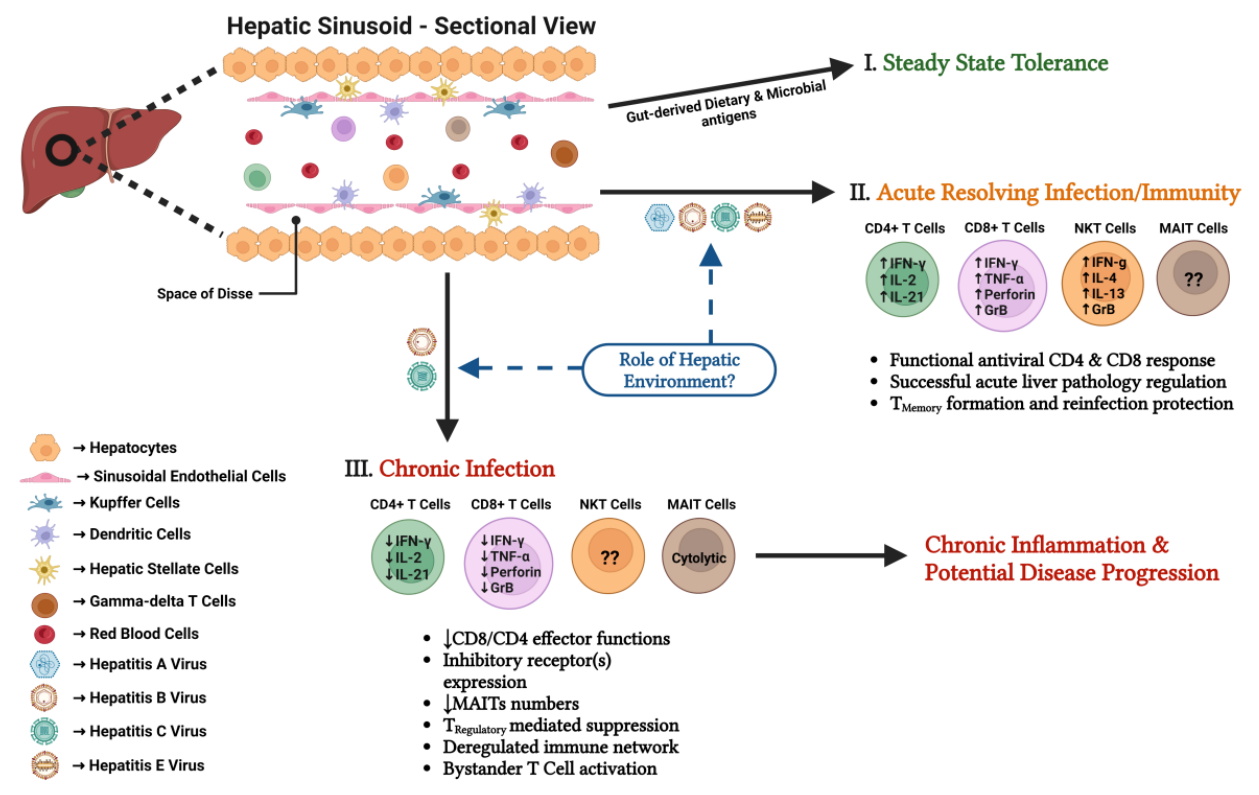
Figure 1. T cell immunity to viral infections in the liver. (I) Under steady state conditions the healthy liver is in a state of immune tolerance towards gut-derived dietary and microbial antigens. (II) In- fection with hepatitis A, B, C, or E virus can result in an acute-resolving infection generally charac- terized by a functional antiviral T cell response, regulation of tissue pathology, and formation of (partial) protective immunity. (III) Infection with hepatitis B and C virus can lead to a chronic infec- tion characterized by T cell dysfunction, dysregulated immune networks, chronic inflammation,